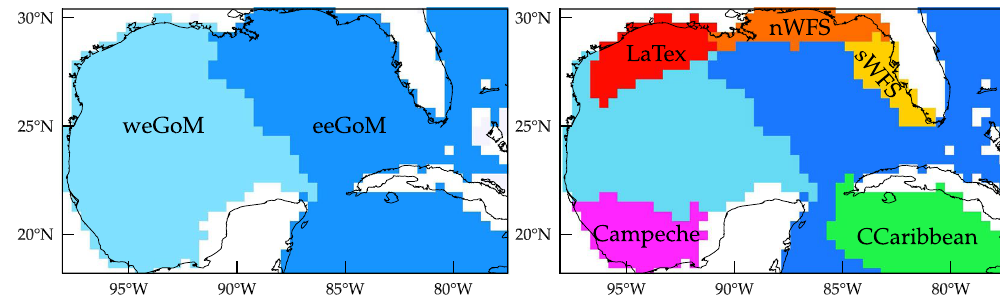
Figure 6. Main (left) and refined (right) dynamical geographies with weakly interacting provinces corresponding to domains of attraction associated to the largest almost-invariant attractors identified. Computations carried using Matlab R2017a (http://www.mathworks.com/) and visualization using Tecplot 360 2016 R2